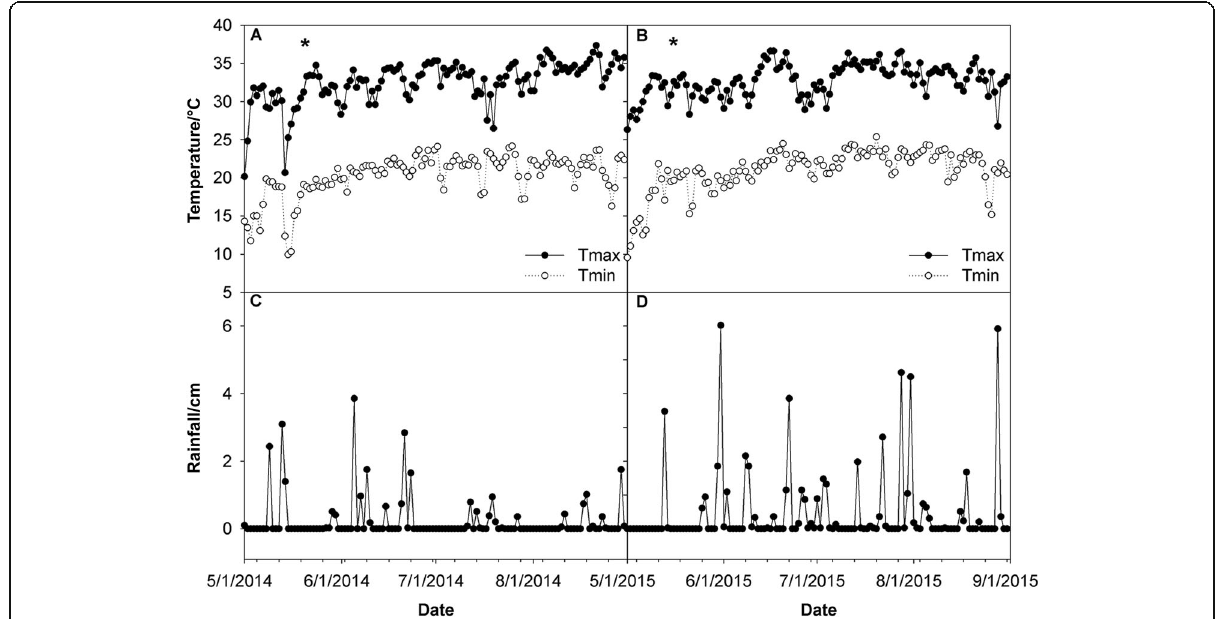
Fig. 1 Environmental data for the 2014 and 2015 growing seasons near Tifton, GA in 2014 and 2015. Data collected include maximum (T max ) and minimum (T min ) daily temperatures in 2014 ( a ) and 2015 ( b ) and rainfall events in 2014 ( c ) and 2015 ( d ). Asterisks in A and B indicate dates of